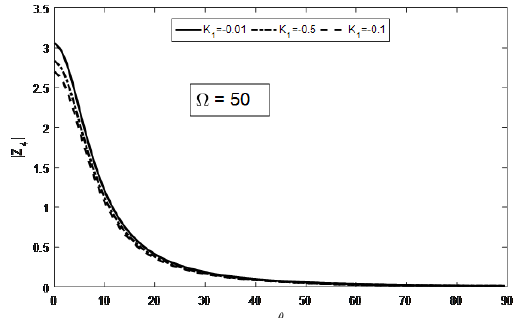
Figure 9: Amplitude ratio of fourth wave against incident angle for different variable thermal conductivity